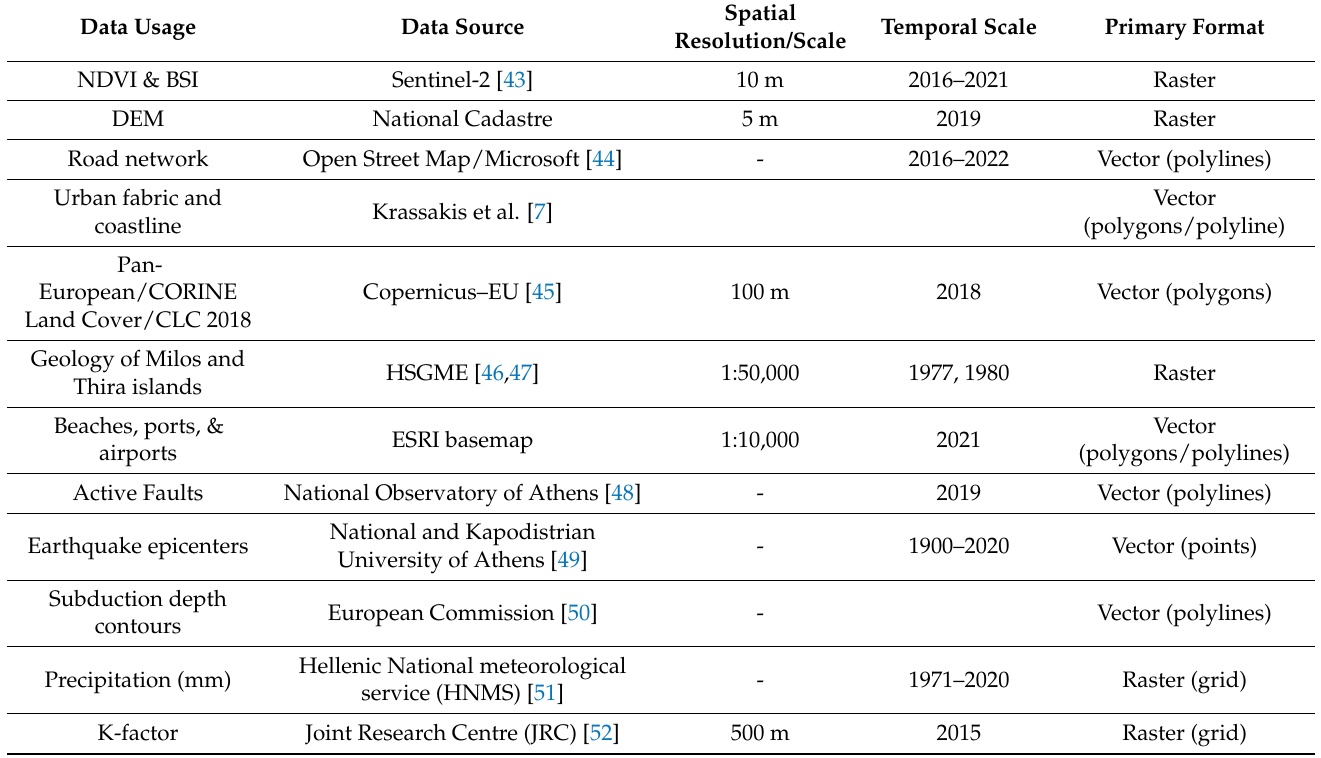
Table 1. Datasets used for multi-hazard